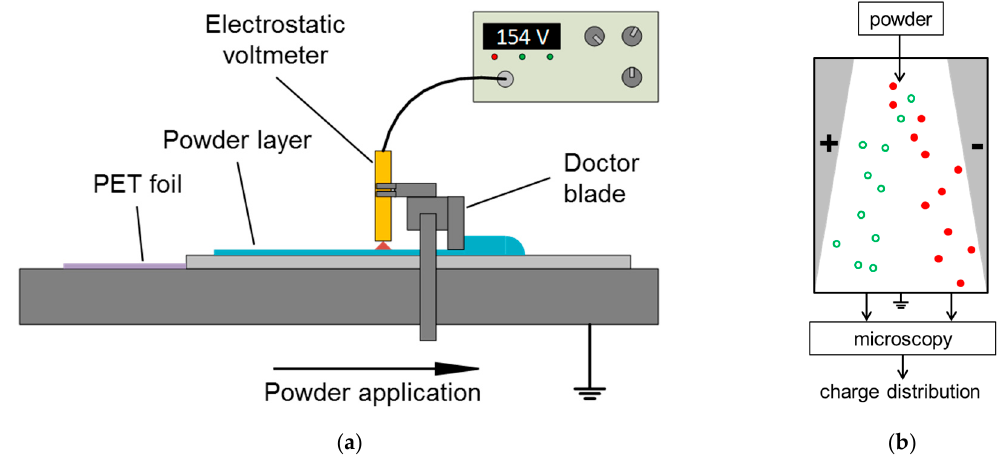
Figure 1. ( a ) Schematic depiction of the model powder spreading setup with the electrostatic voltmeter for measuring a powder’s surface potential during powder spreading. ( b ) Schematic functionality of the q/d-meter.